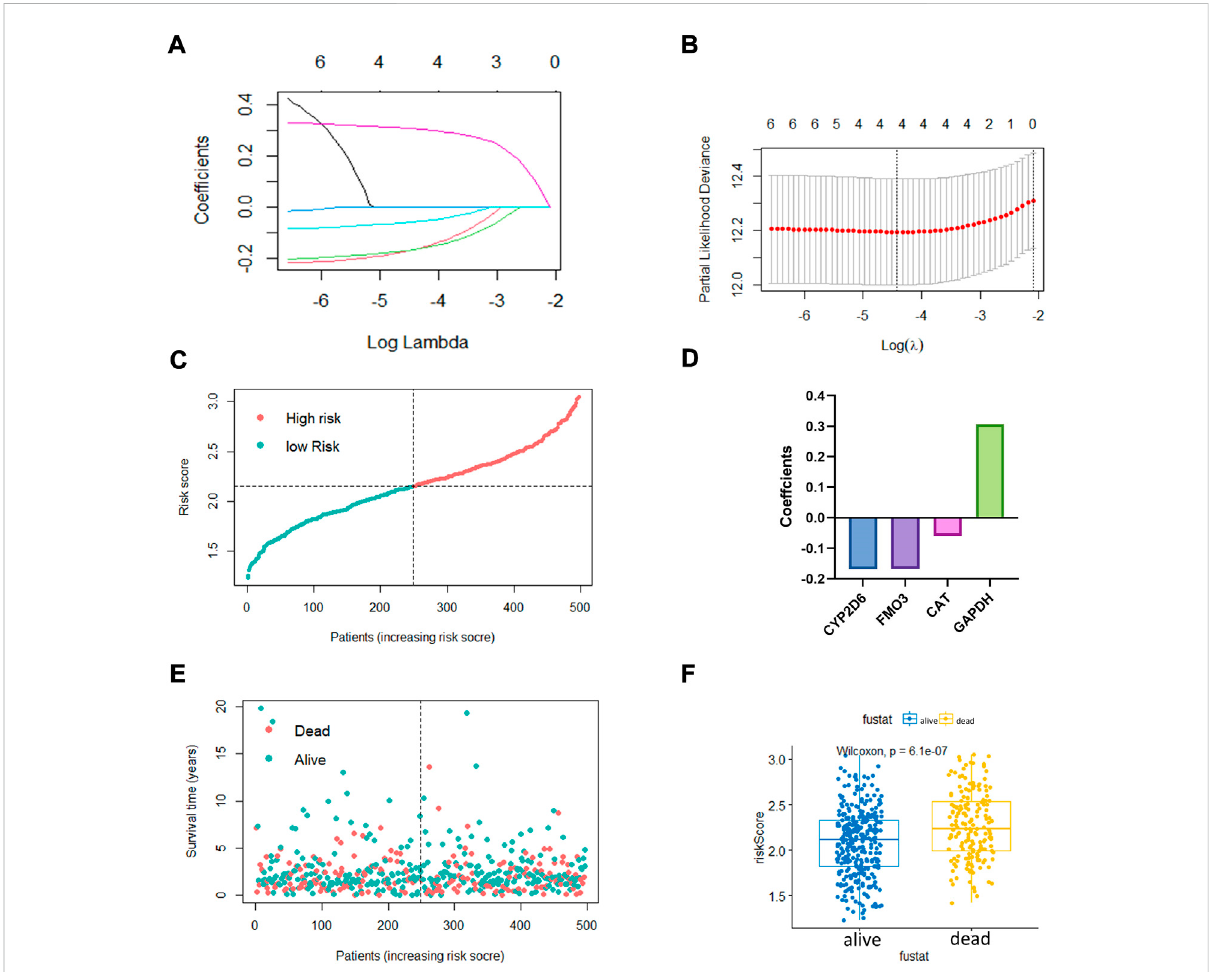
FIGURE 2 The construction of oxidative stress genes based prognostic risk model. (A,B) Establishment of model using least absolute shrinkage and selection operator (LASSO) Cox regression analyses. (C) Distribution of risk score. (D) Coef fi cients of four genes. (E,F) Distribution of survival status and risk score level of alive and dead